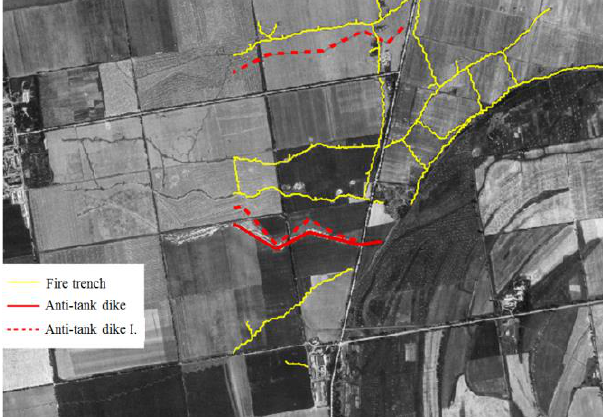
Figure 5. Object reconstruction on archive aerial photographs